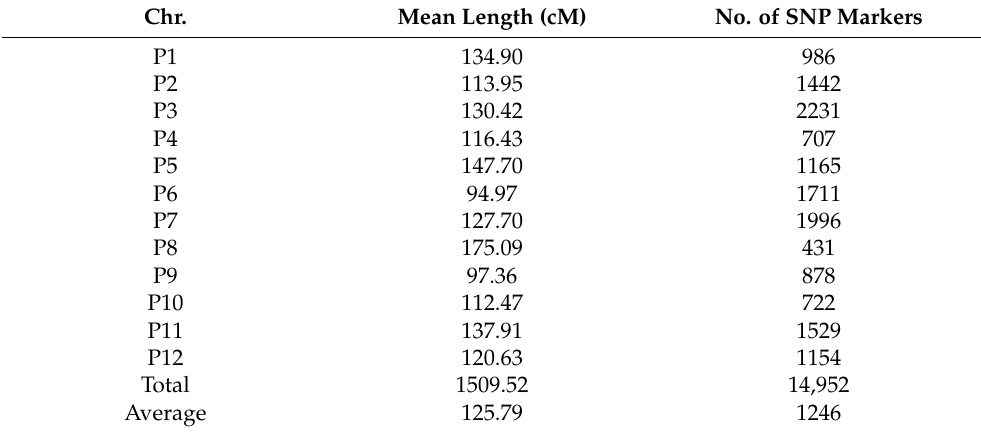
Figure 1. Distribution of 766 QTL surveyed in 29 linkage mapping studies across five different trait classes in chile peppers ( Capsicum spp.). Table 2. Length and number of markers for each chromosome of the constructed Capsicum spp. consensus